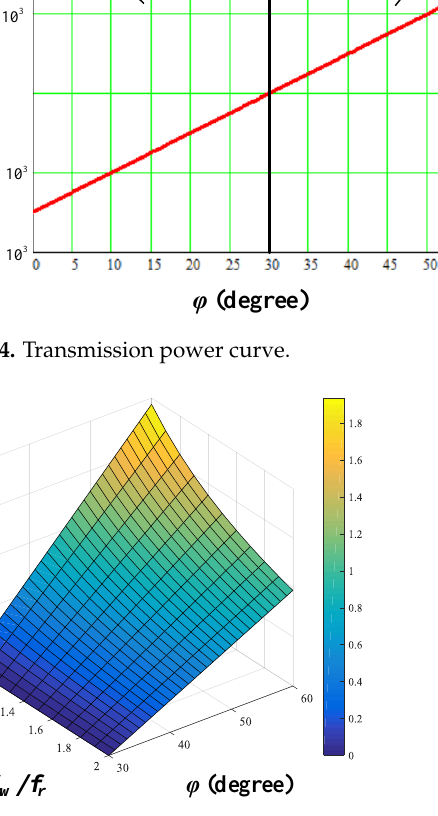
Figure 5. Gain Figure 5. Gain curve. Figure 5. Gain curve.